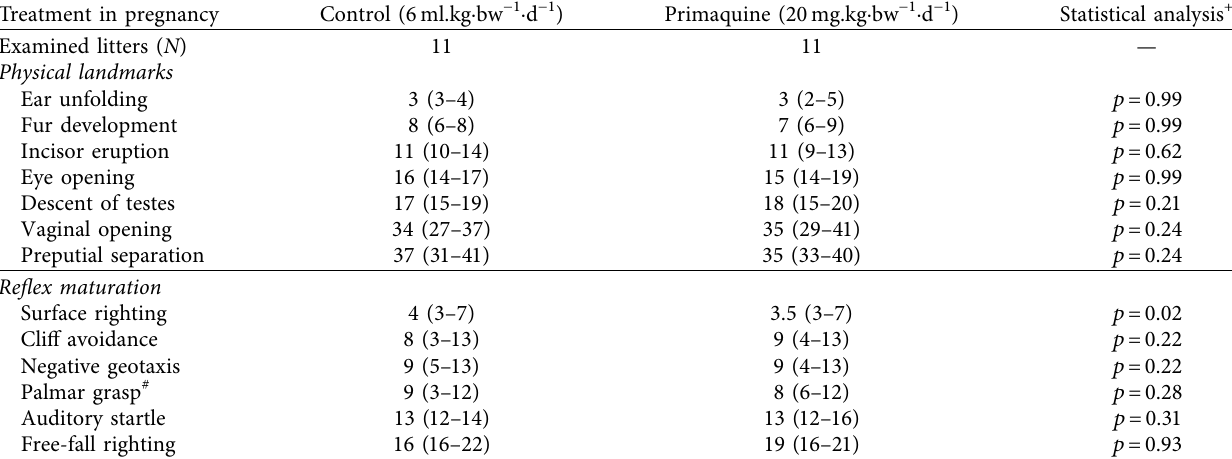
Table 3: Somatic and neurodevelopmental landmarks in the offspring of female rats treated orally with primaquine during pregnancy (GD